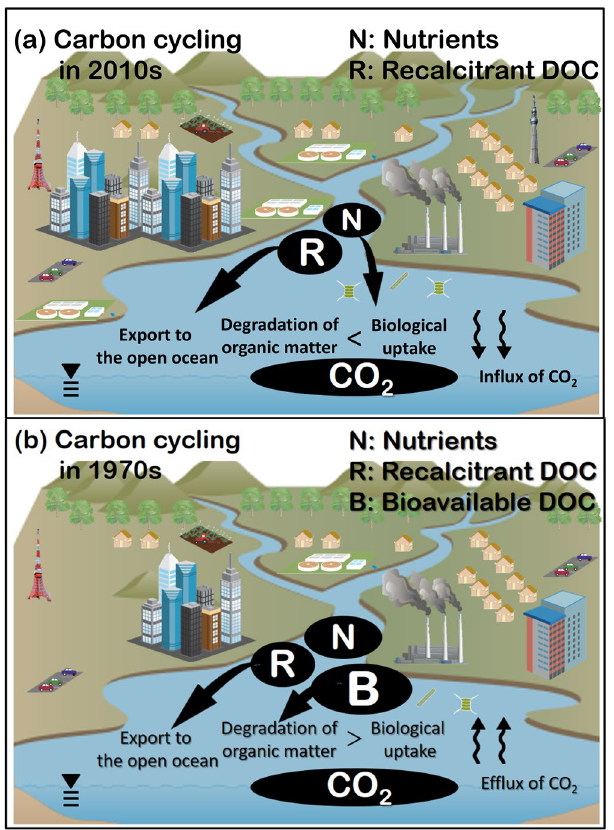
Figure 6. Carbon cycling model in Tokyo Bay in ( a ) 2011–2012 and ( b ) 1970s. Each carbon flux is shown in Table S4. The illustration was created by the image library, which was free material provided by Integration